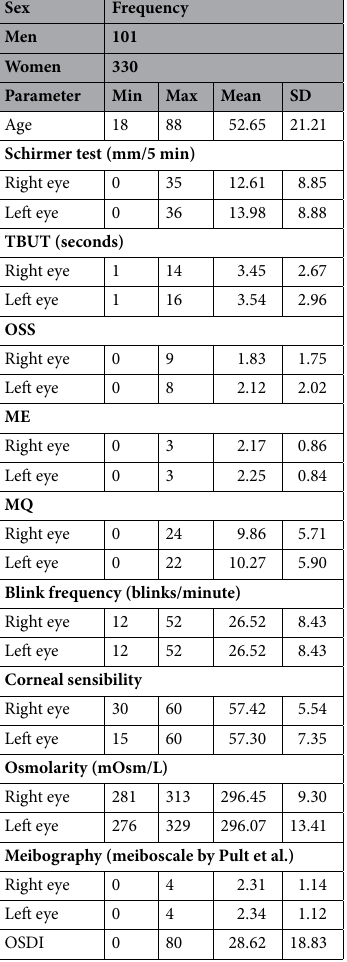
Table 1. Demographics and clinical data. Max maximum, ME meibomian gland expressibility, MQ meibum quality, Min minimum, mm millimetres, mOsm/L milliosmole/litre, OSDI ocular surface disease index, OSS ocular surface staining, SD standard deviation, TBUT tear film break up